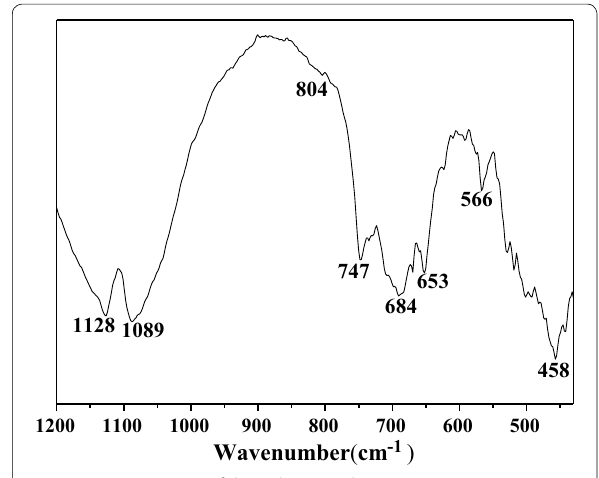
Fig. 3 FT-IR spectrum of the VAlPO 4 catalyst